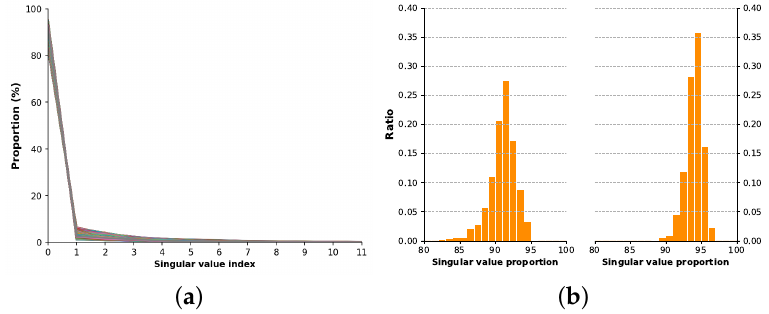
Figure 3. Proportion of the historical load matrix (HLM) singular values (SVs). The HLMs stem from 2018 and are 14 × 12 in size. ( a ) Proportion of each SV; ( b ) proportion of (left) the first SV and (right) the first